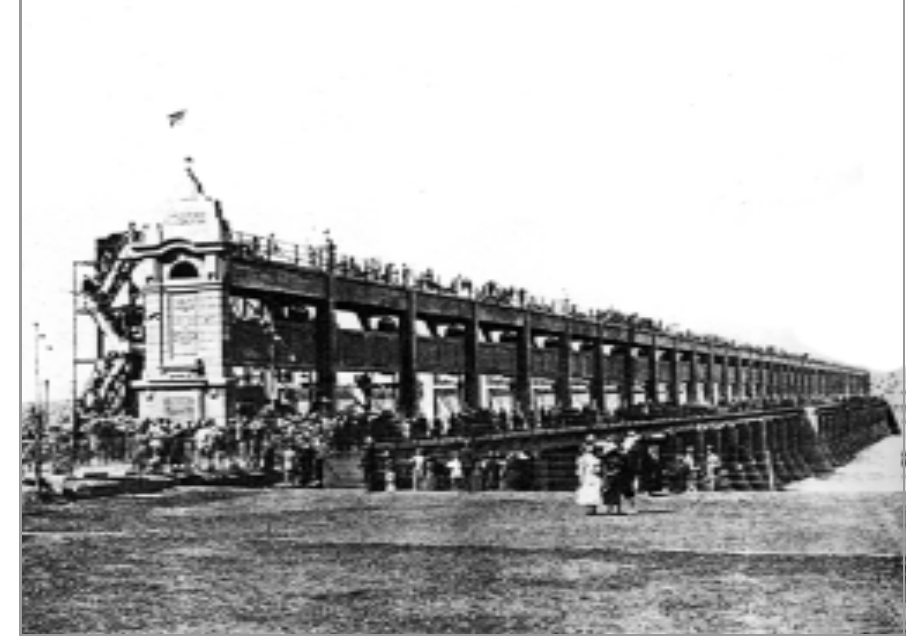
Illustration 2: The Barrage in the Vaal River at the time of its inauguration in 1923.